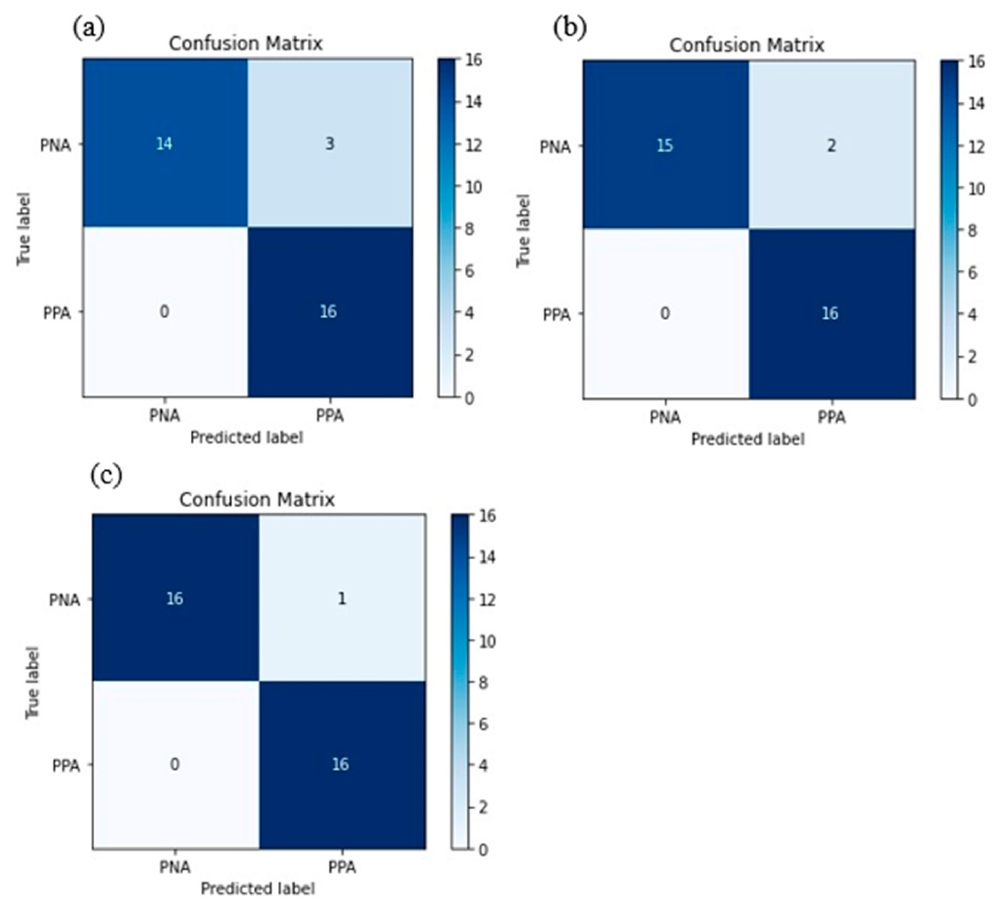
Figure 3. The confusion matrix for the LR models. ( a ) Standard DA feed-forward LR. ( b ) Backward DA feed-forward LR. ( c ) Forward stepwise DA feed-forward LR .